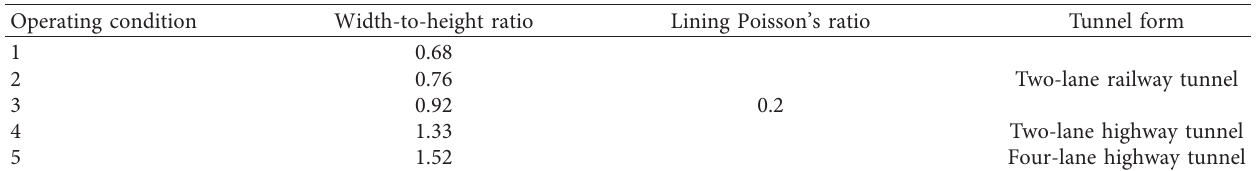
Table 2: Operating conditions for the dynamic response analysis of tunnel structures in different